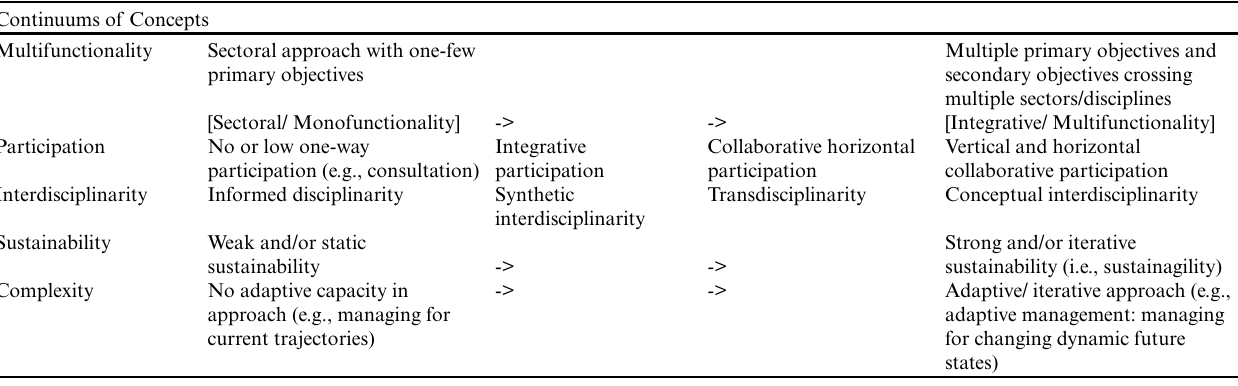
Table 5 . Continuums for each of the five concepts discussed. Some are more developed than others, for example Lattuca’s (2003) continuum for interdisciplinarity vs the rough comparison for complexity, but the overall objective of this table is to demonstrate the range of application for each of the concepts. In an integrated landscape approach (ILA), ideally more of these concepts will be engaged toward the right end of the table, but will be largely dependent on the capacity and interest that exists. See sections on each concept for more details about